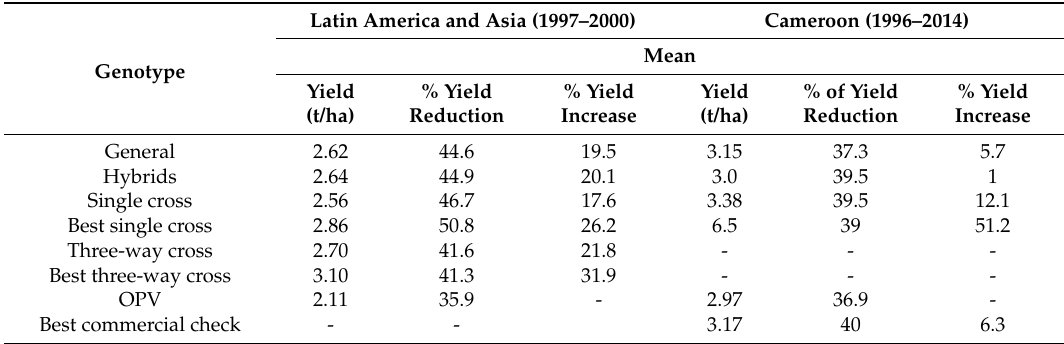
Table 4. Case studies showing grain yield improvements of some maize genotypes evaluated under selected acidic soil environments from 1998 to